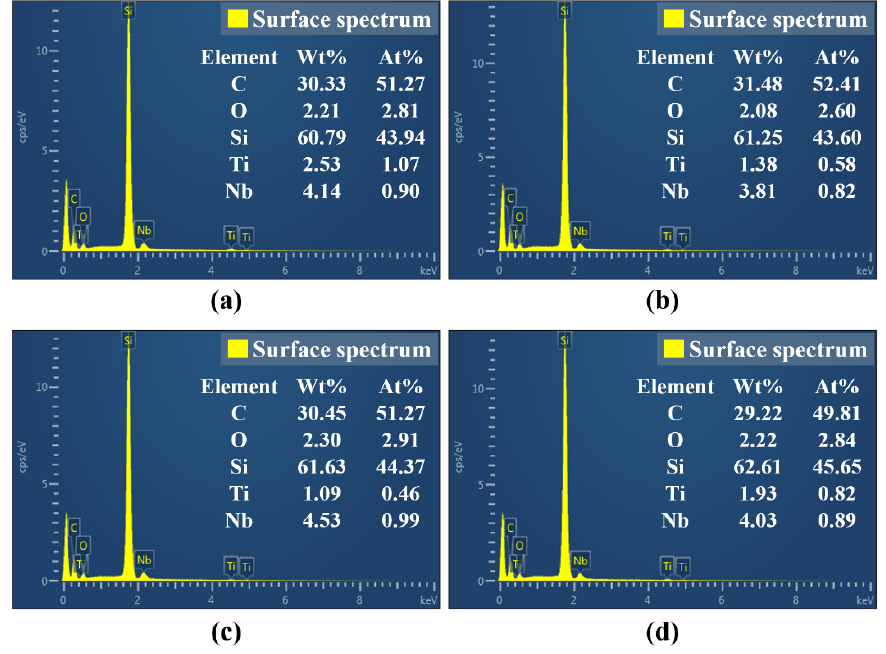
Figure 11. The elemental content of polished surfaces under different pulse energies. ( a ) 20 µ J, ( b ) 25 µ J, ( c ) 35 µ J, ( d ) 45 µ J. (Figures ( a ), ( b ), ( c ) and ( d ) in Figure 11 are the surface spectrum of figures ( a1 ), ( b1 ), ( c1 ) and ( d1 ) in Figure 9, respectively).